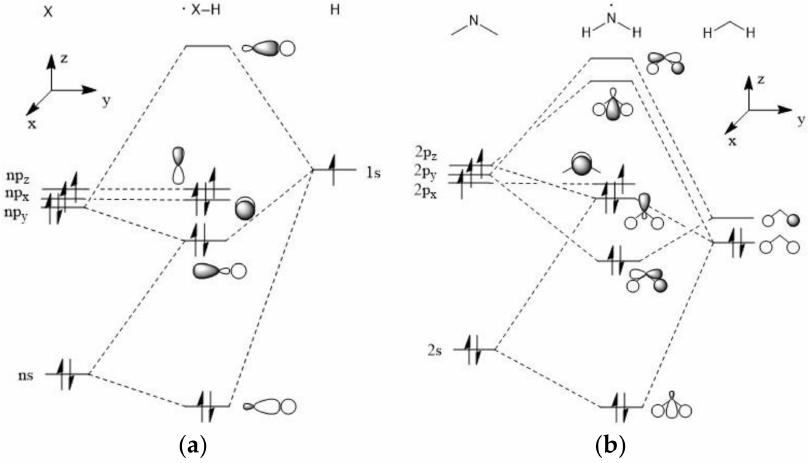
Figure 3. Orbital diagram for the radical fragments HX • ( a ) and • NH 2 ( b